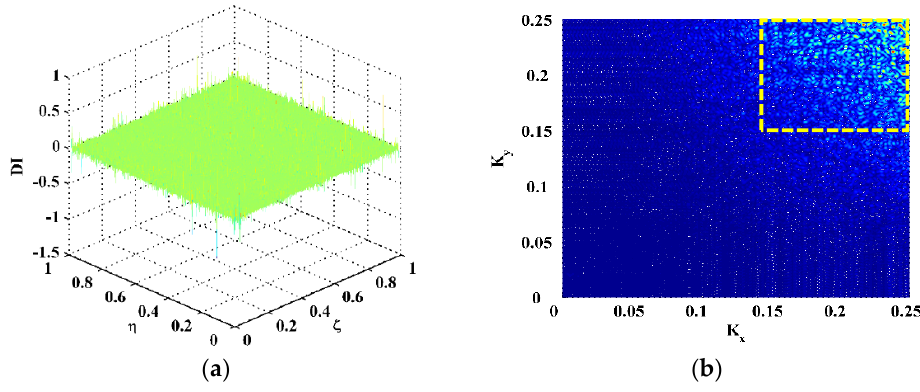
Figure 3. ( a ) DI and its ( b ) wavenumber spectrum for Scenario V.